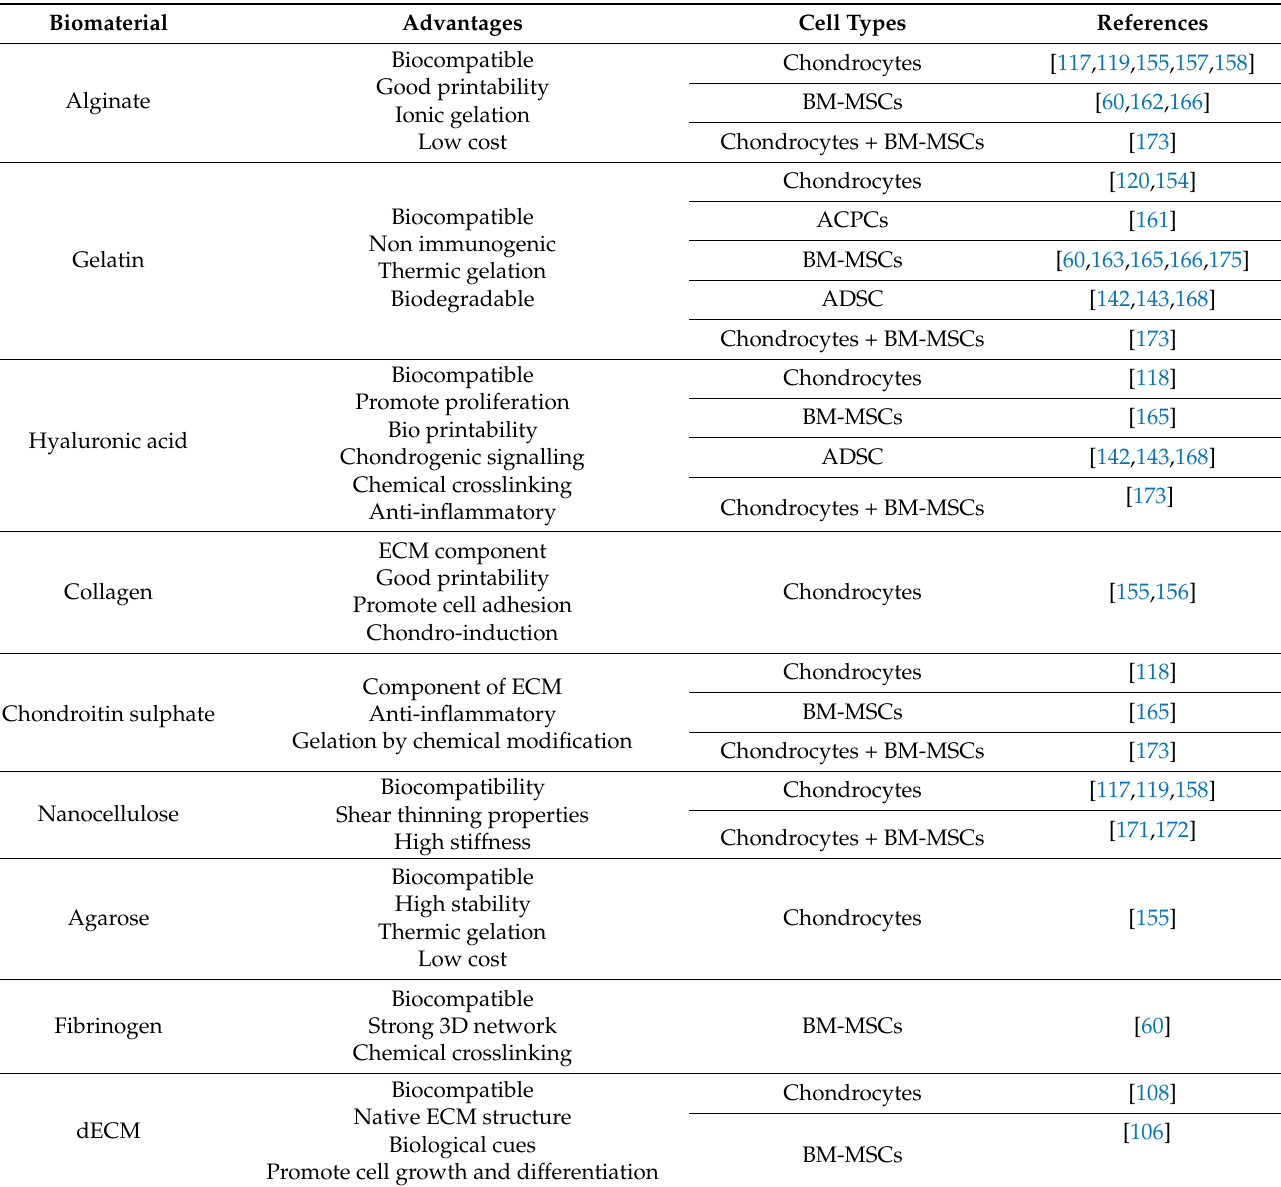
Table 1. Summary of the advantages of the various biomaterials used to date in extrusion-based 3D printing depending on the embedded cell types for cartilage tissue